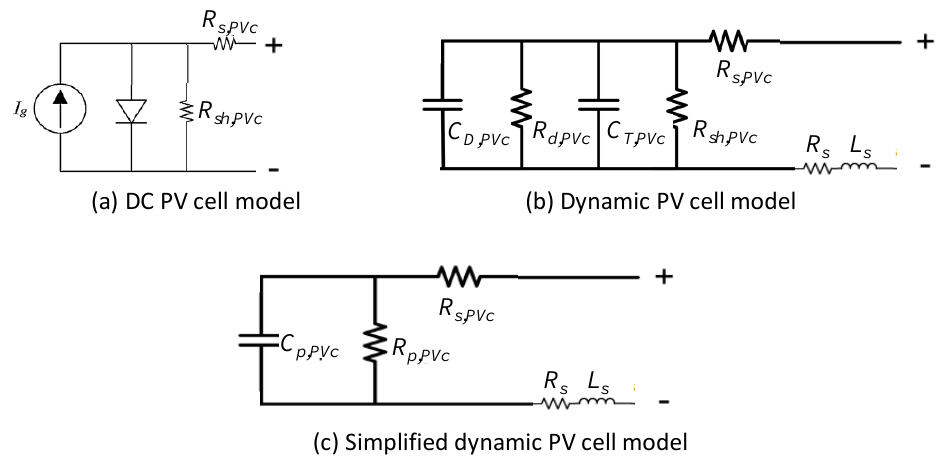
Figure 7. DC and dynamic models of the active electrical circuitry for a PV cell. When PV cells are arranged in series and parallel in a PV module, the dynamic pa- rameter values of the module are the combination of the individual cell characteristics.